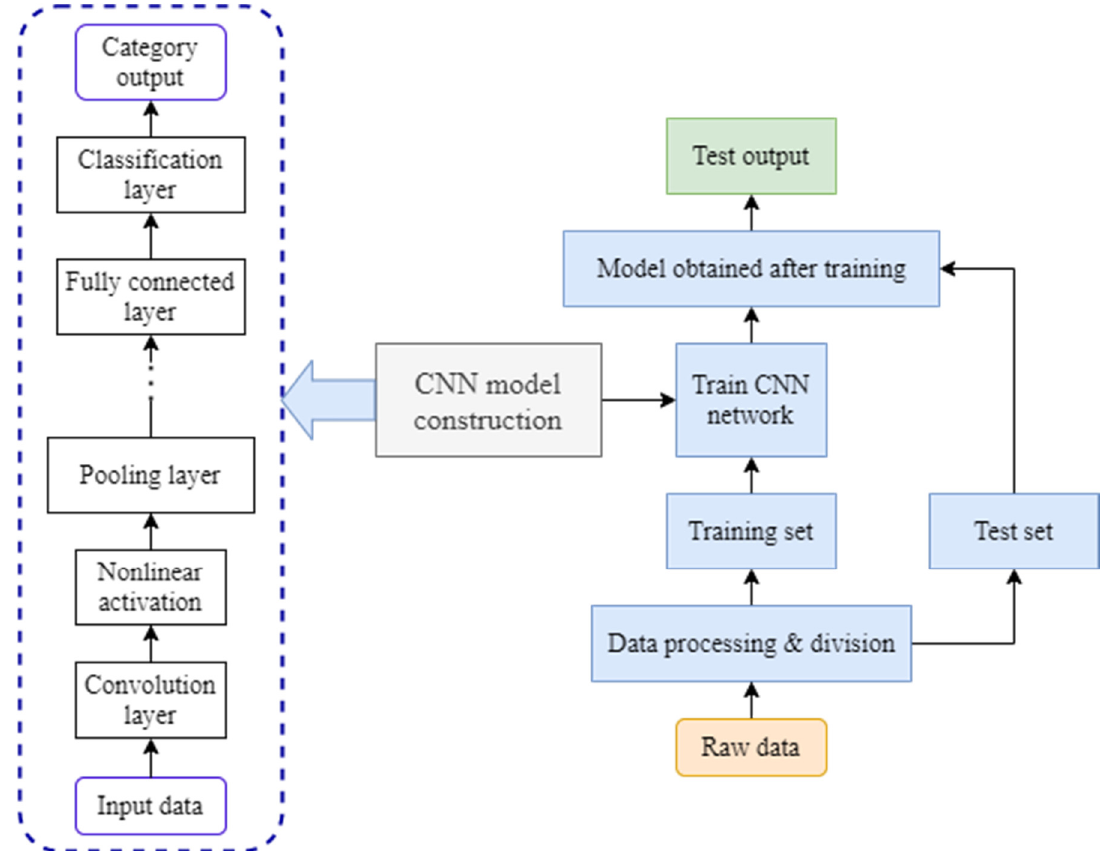
Figure 13. CNN fault diagnosis framework.